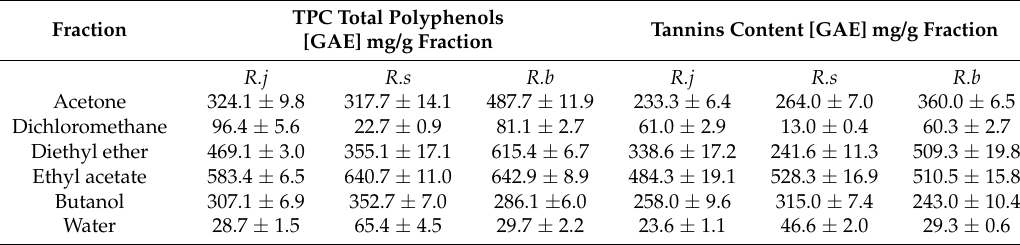
Table 3. Total polyphenols and tannins content in studied extracts and fractions. Data were expressed as mean ± SD, performed in at least three independent experiments, assayed in triplicate.